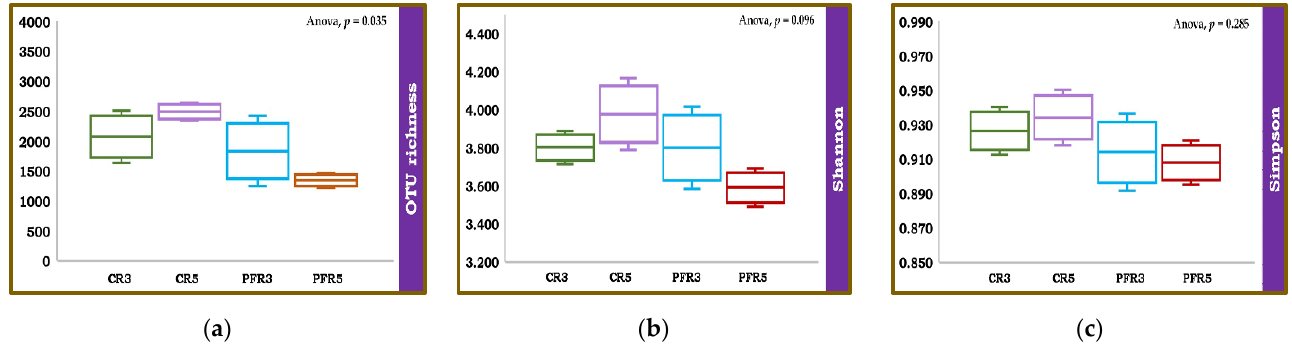
Figure 3. Box-and-whisker plots, based on Chao1 ( a ), Shannon ( b ), and Simpson ( c ) diversity indices showing fungal richness and diversity in the calyx-end and peel tissues derived from bagged (i.e., CR5 and PFR5) and unbagged (i.e., CR3 and PFR3) fruit. The Chao1 index is commonly used to estimate the number of OTUs or species in samples. The Shannon and Simpson diversity indices are common measures of diversity, which reflect the richness and evenness of the samples. Table 2. Comparison of abundance-based estimator of OUT richness according to Chao1 index in different samples of calyx-end and peel tissues derived from bagged (i.e., CR5 and PFR5) and un- bagged (i.e., CR3 and PFR3) fruit. Green boxes contain the values of mean and standard deviation determined for each apple part. White boxes contain p -values of the results of pairwise comparisons using the Student t -test. CR3